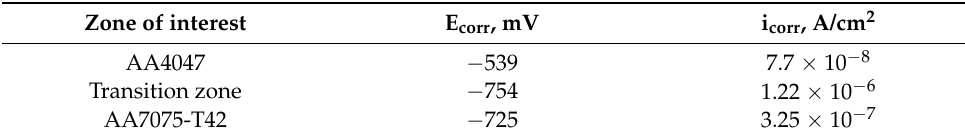
Figure 16. Potentiodynamic polarization curve for studied samples. Table 6. Polarization parameters for studied